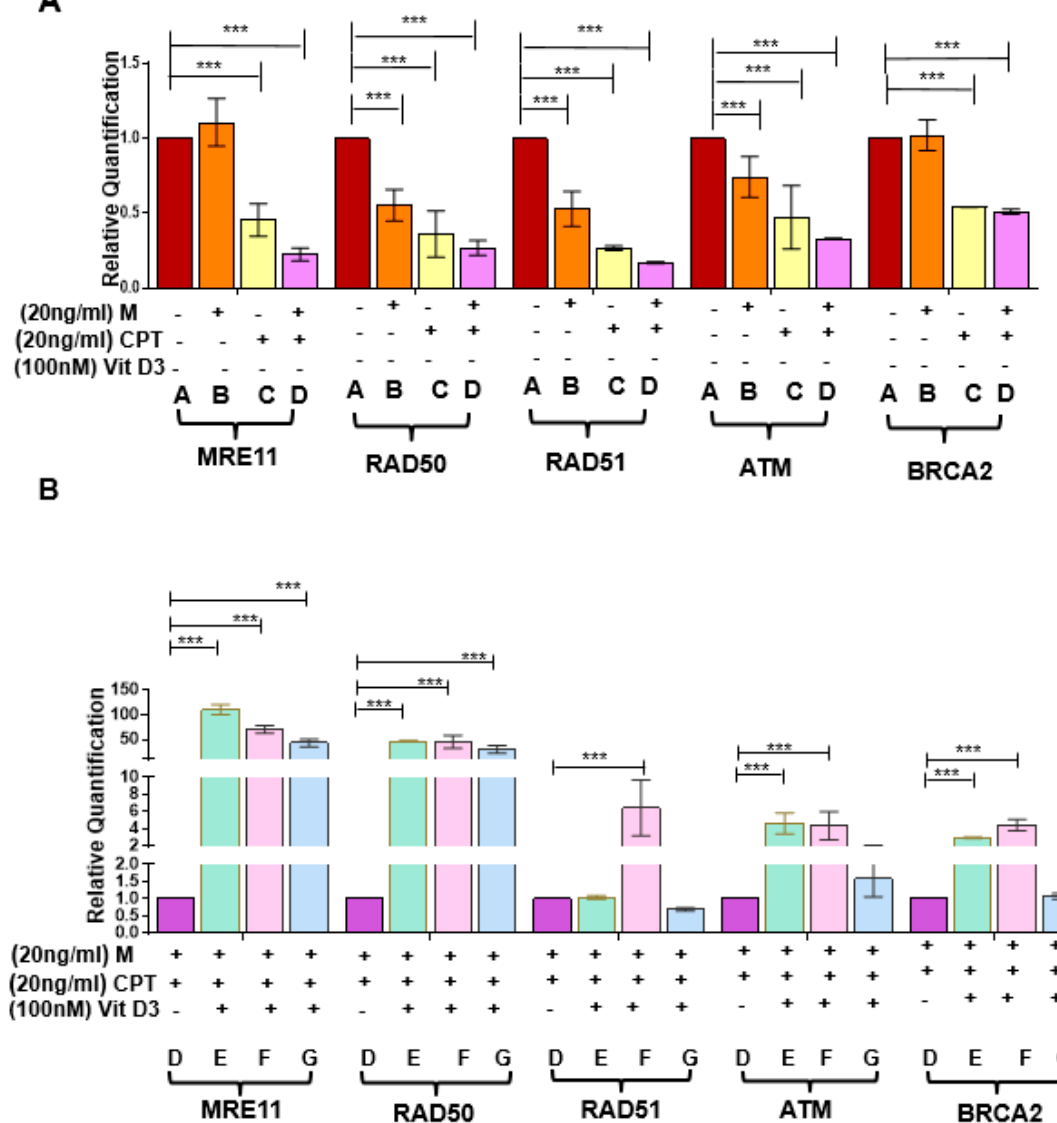
Figure 6. E ff ect of VitD3 on RNA expression of DNA repair genes in the presence of DNA damage inducers. ( A ) mRNA expression of DSB repair sensors (MRE11 and RAD50), e ff ectors (BRCA2, RAD51), and ATM in DES-MMSCs treated with the double-strand DNA damaging agents CPT and Mirin. ( B ) The mRNA expression levels of DSB repair sensors (MRE11 and RAD50), e ff ectors (BRCA2, RAD51), and ATM were measured in Mirin- and CPT-treated DES-MMSCs with and without VitD3 at di ff erent time points. Full experimental design and explanation of di ff erent groups (A–G) can be found in Figure S3. The mRNA levels were normalized to 18S rRNA, and normalized values were used to generate the graph. Data are presented as mean ± SEM of triplicate measurements with *** p < 0.001.